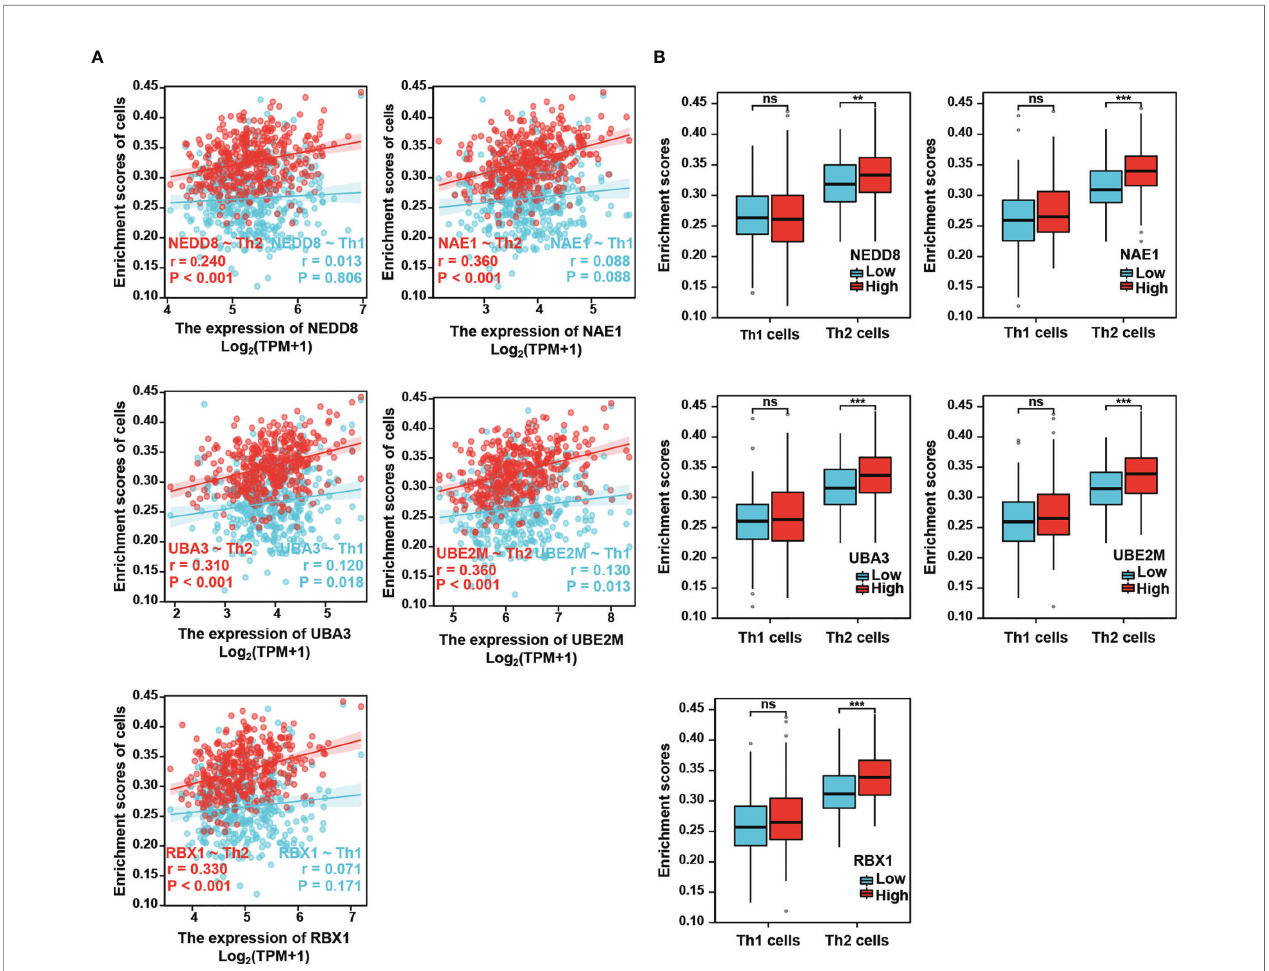
FIGURE 3 | Neddylation pathway positively correlates with the in fi ltration of Th2 cells, but not Th1 cells. (A) Neddylation pathway components positively correlate with the in fi ltration of Th2 cells, but not Th1 cells. (B) The in fi ltration of Th2 cells, but not Th1 cells, is signi fi cantly increased in the activated neddylation pathway group. **P<0.01, ***P<0.001, ns, not signi fi cant, for the indicated